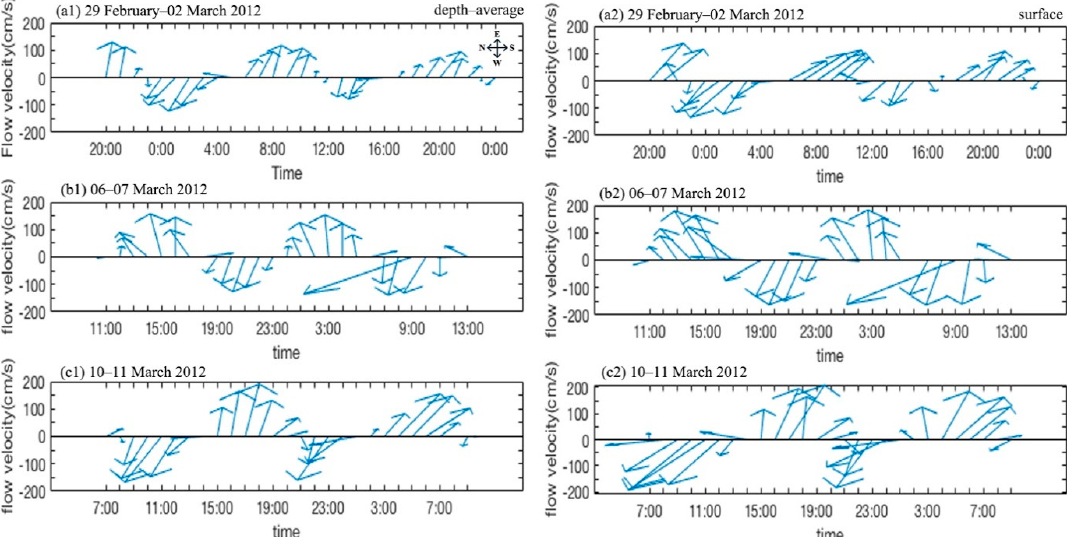
Figure 3. Flow’s velocity and direction at average depth for 29 February–02 March